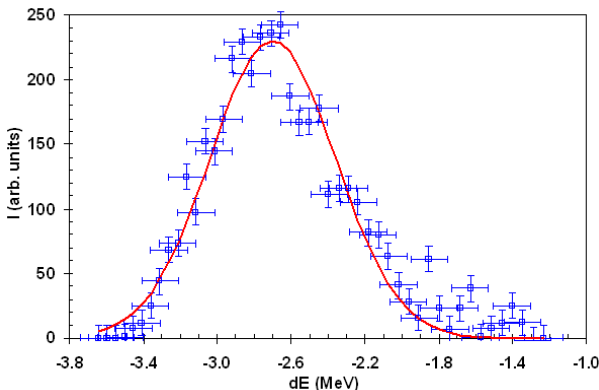
sign.FIG. 12. (Color) Beam energy profile measured at the second SCL cavity with the BCM in an energy scan. The beam energy width (sigma) is approximately 0.33